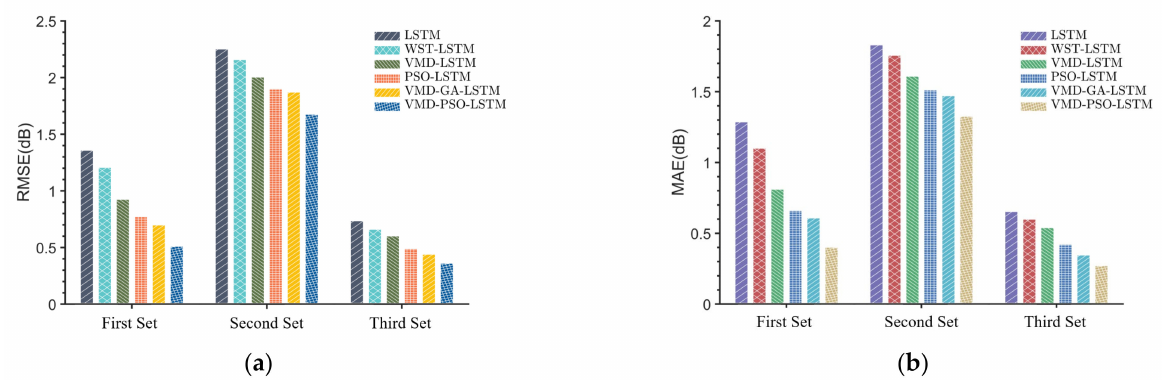
Figure 17. RMSE and MAE indicators of the six methods (LSTM, WST − LSTM, VMD − LSTM, PSO − LSTM, VMD − GA − LSTM and VMD − PSO − LSTM methods): ( a ) RMSE ; ( b ) MAE